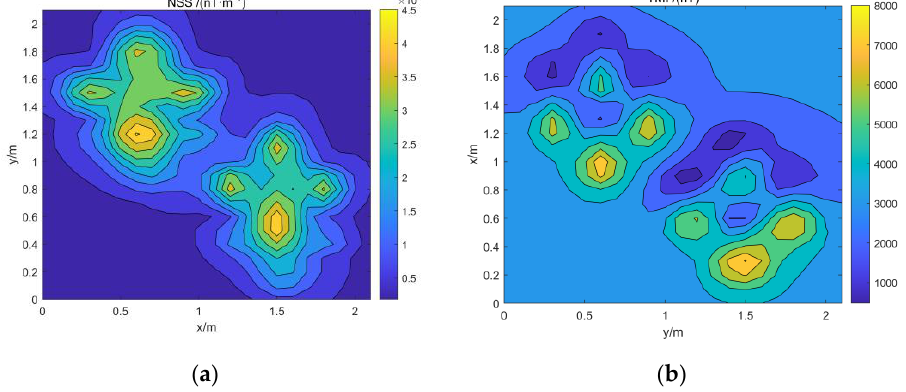
Figure 14. Actual data: ( a ) Actual data for normalized magnetic source strength; ( b ) actual data of the total magnetic field.